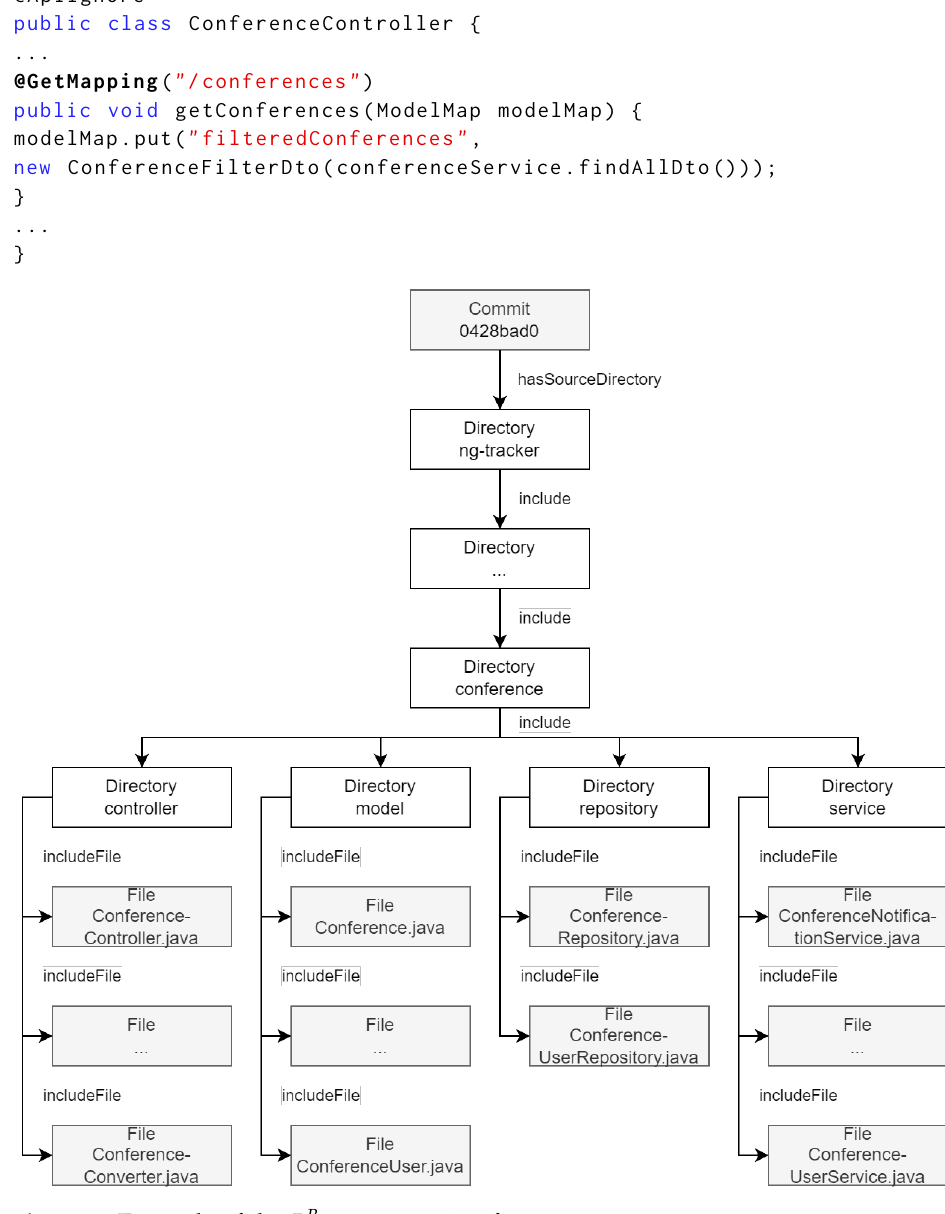
Figure 4. Example of the P B representation